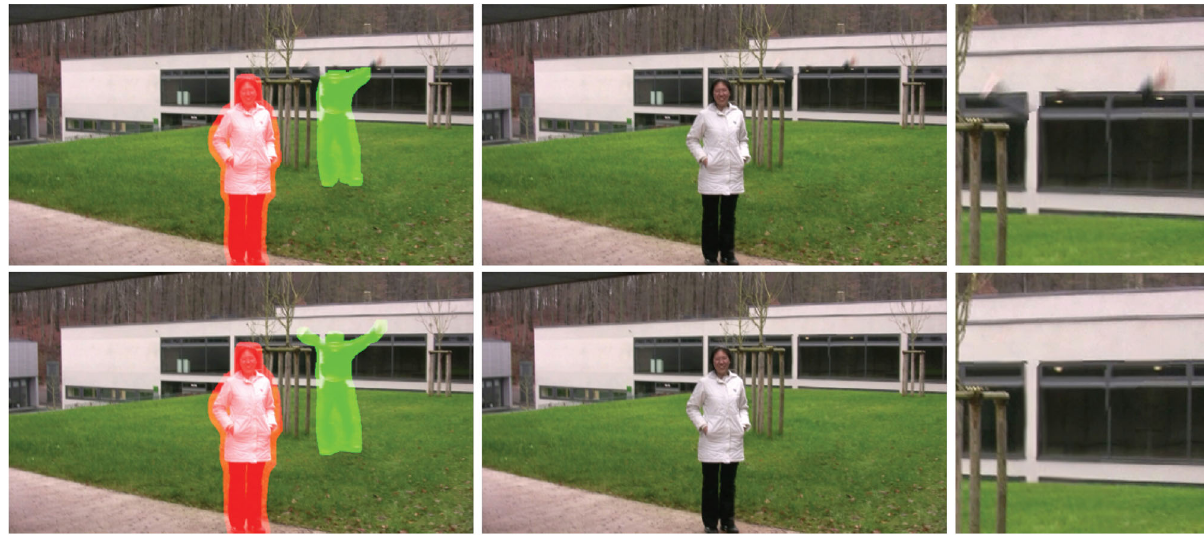
Fig. 13 Results of object removal using masks computed by OSVOS (top) and our method (bottom). Left to right: segmentation mask, resulting object removal in one frame, zooms. When the segmentation masks do not fully cover the object (OSVOS), the resulting video contains visible artifacts (the hand of the man remains after object removal).